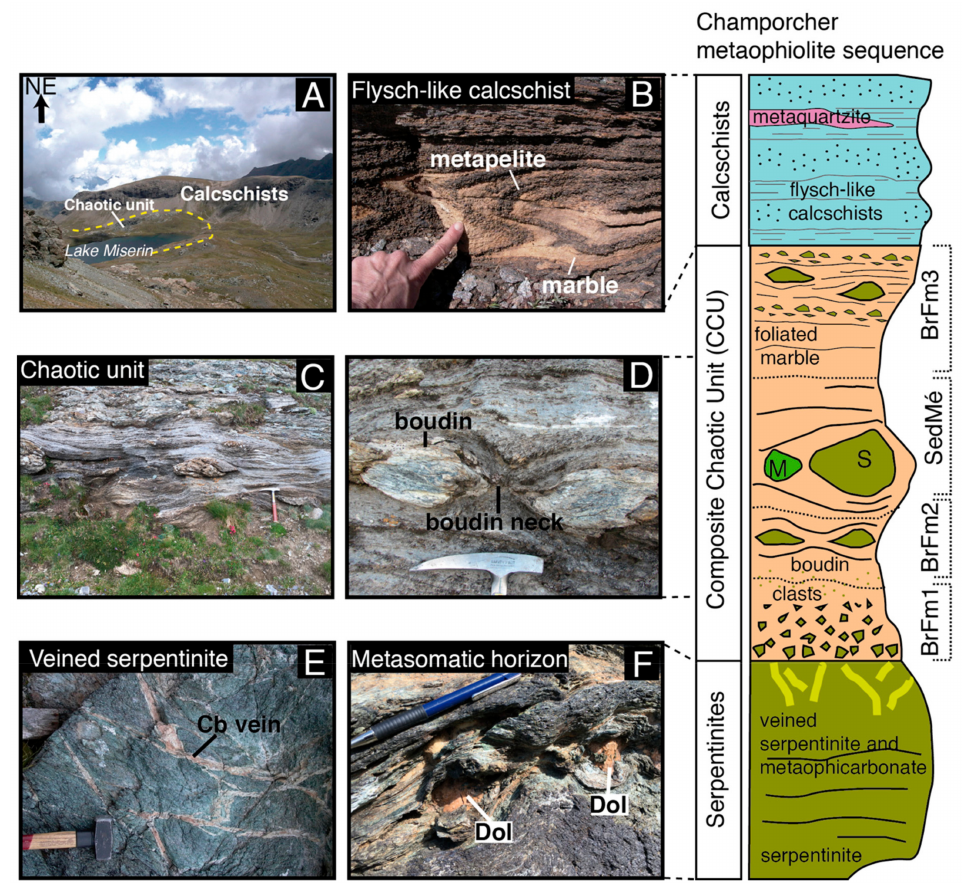
Figure 3. Panoramic and outcrop views of the Champorcher valley metaophiolite sequence near Lake Miserin. The main reconstructed stratigraphy of the Composite Chaotic Unit (CCU) is synthetized in the stratigraphic section (to the right). ( A ) Panoramic view of the CCU and overlying calcschists near Lake Miserin (high Champorcher valley). ( B ) Outcrop view of the calschist unit characterized by compositional layering defined by alternating metapelite and marble (interpreted to derive from an original bedding S0 of a flyschoid sequence; see text). ( C ) Block-in-matrix fabric of the CCU consisting of ultramafic blocks and clasts embedded in Cb-rich or calcschist foliated matrix. ( D ) Close-up of boudinaged ultramafic clasts in the CCU. ( E ) Top part of the serpentinite basement cut by Cb-rich veins (“veined serpentinites”). ( F ) Outcrop view of the metasomatic horizon at the contact between the CCU and underlying